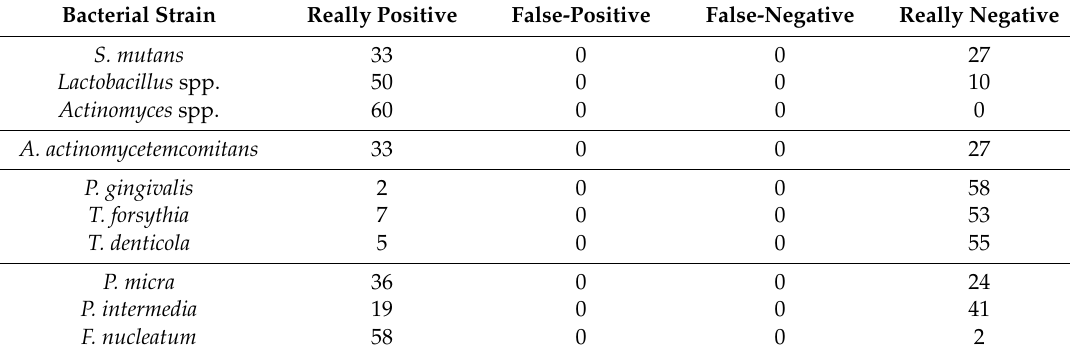
Table 4. Comparison of the tested and the reference method [6] for cariogenic and periodontal bacteria (red and orange complex and A. actinomycetemcomitans ) determination in clinical samples. Bacterial Strain